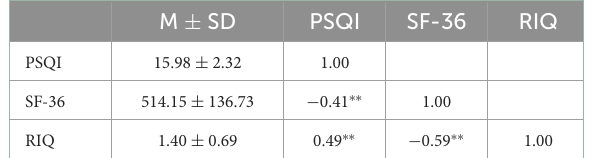
TABLE 2 Descriptive statistics and intercorrelations among study variables.